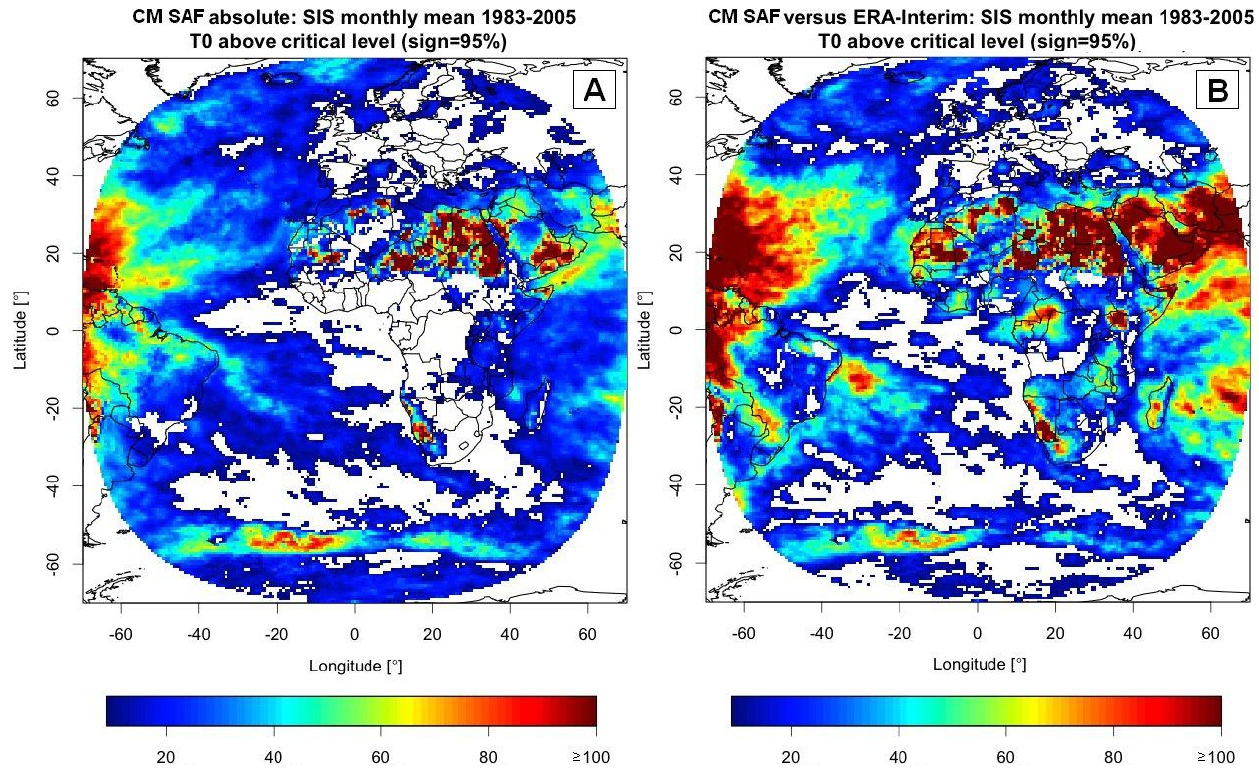
Figure 7. T values above a significance level of 95% for CM SAF SIS data using absolute 0 testing ( A ) and relative testing versus ERA-Interim SIS data ( B